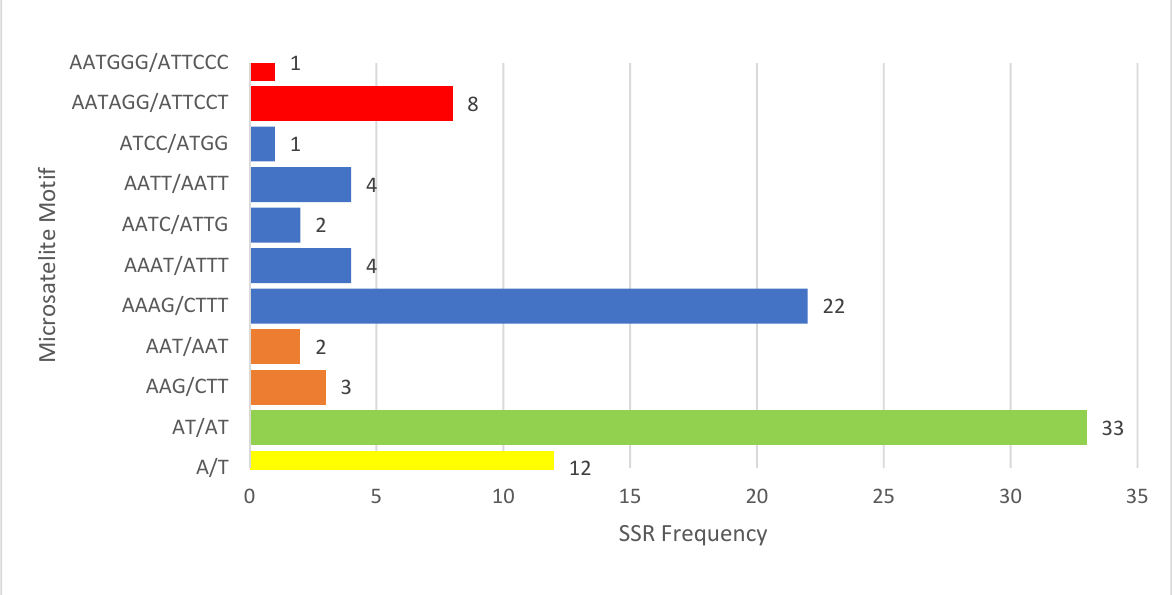
Figure 3. Microsatellite frequency classified by microsatellite motifs found in the cp genome of V. floribundum.